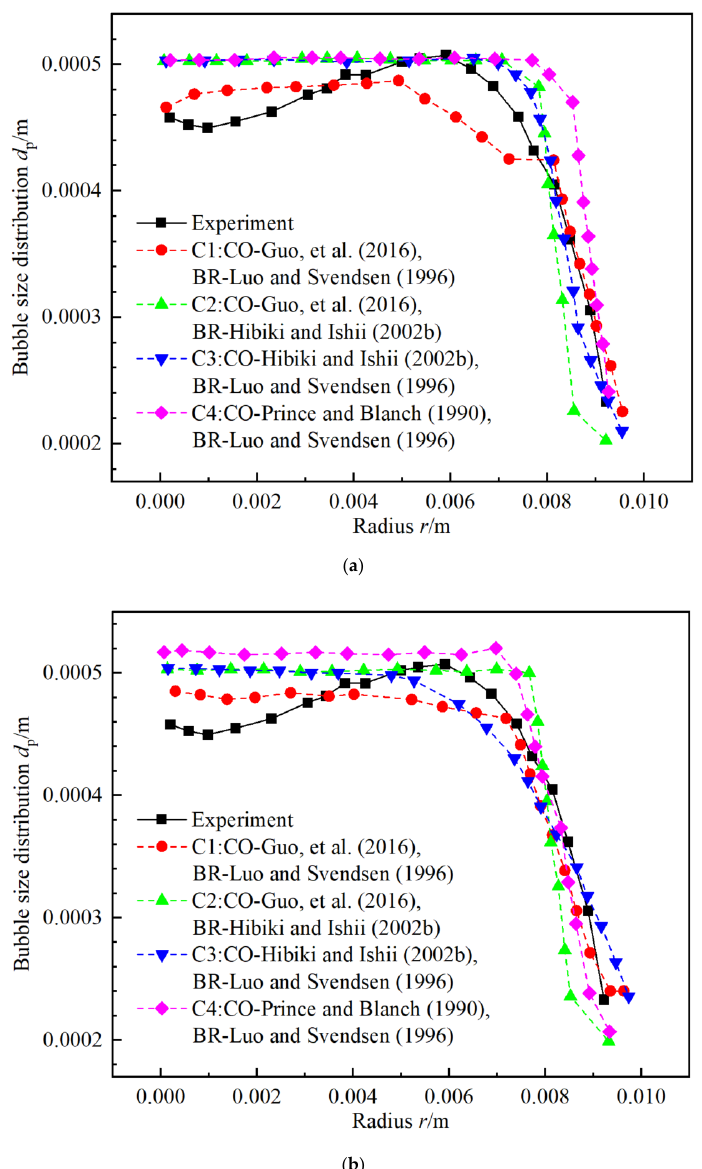
Figure 4. Bubble size distribution of SMD d p of various combinations of coalescence and breakup kernel with model of D d [8], f [46] and DEBORA-1 experiment ( P = 2.62 MPa) [28] at z = 3.5 m. ( a ) with N n of Kocamustafaogullari and Ishii [36], and ( b ) with N n of Basu [40].